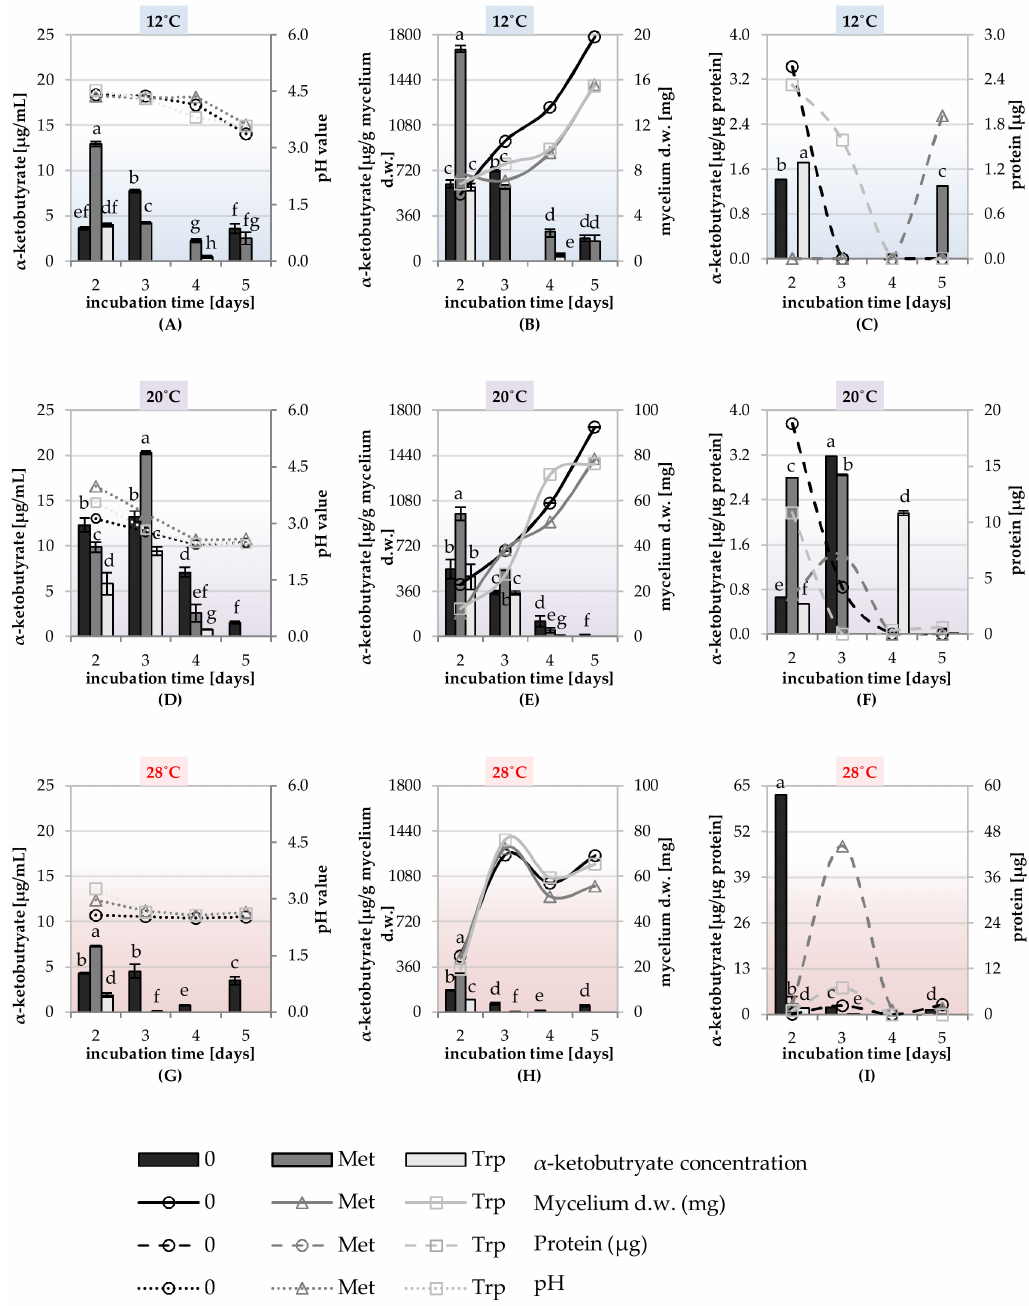
Figure 10. The ACC-deaminase activity and e ffi ciency of ACC-deaminase synthesis of Trichoderma DEMTkZ3A0 cultures after 5 days of incubation at 12 ◦ C ( A , B , C ), 20 ◦ C ( D , E , F ) and 28 ◦ C ( G , H , I ). Results are represented as nMol of α -ketobutyrate / h / mL (ACC-deaminase activity) and as nMol of α -ketobutyrate / g mycelium d.w. or nMol of α -ketobutyrate / h / mg protein (e ffi ciency of ACC-deaminase synthesis). Bars represented standard deviations (SD). Values followed by di ff erent letters are significantly di ff erent (one-way analysis of variance (ANOVA) followed by a Tukey’s post hoc test with the significance evaluated at p <